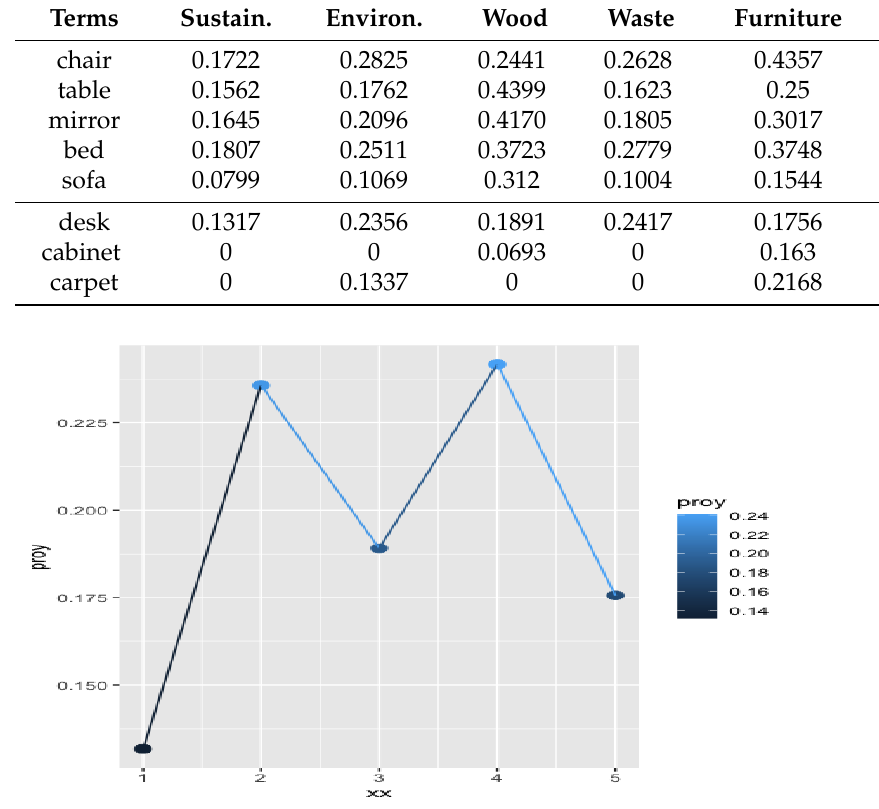
Figure 6. Representation of the projection of the object “desk” on the universe U = {“sustainable”, “environment”, “wood”, “waste”, “furniture” }.